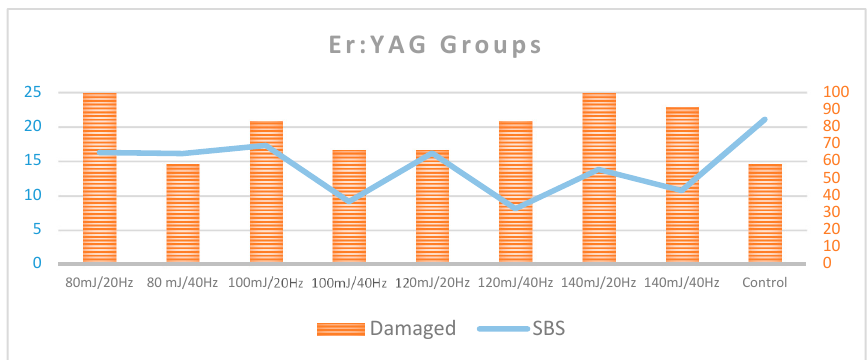
Figure 10. Summarize the mean SBS value percentages and the percentage of damaged enamel in each of the Er,Cr:YSSG groups.